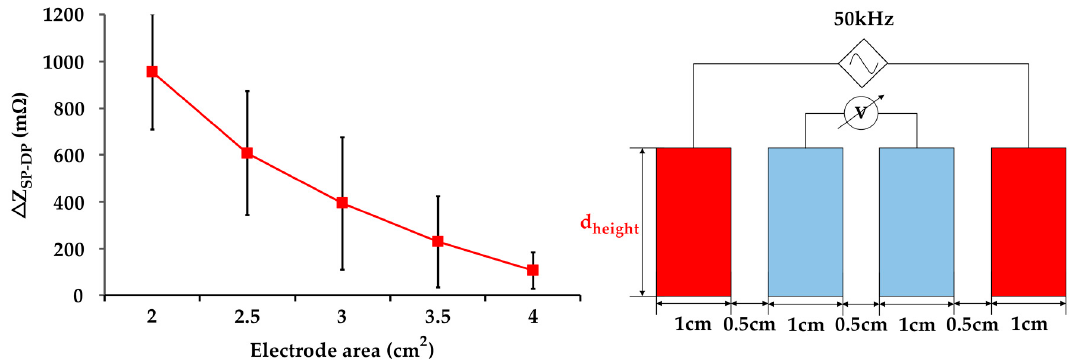
Figure 7. The influence of different electrode cross-sectional areas on IPG resolution measurement (n =